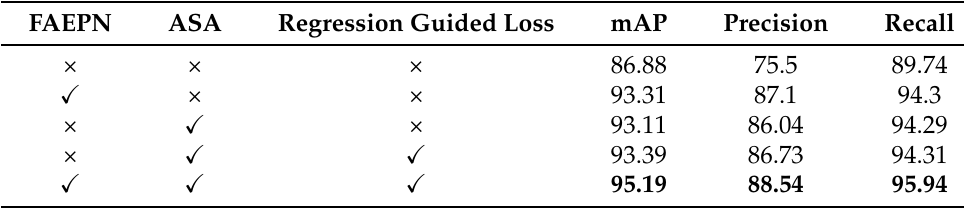
Table 1. Effects of the proposed components on the SSDD dataset.